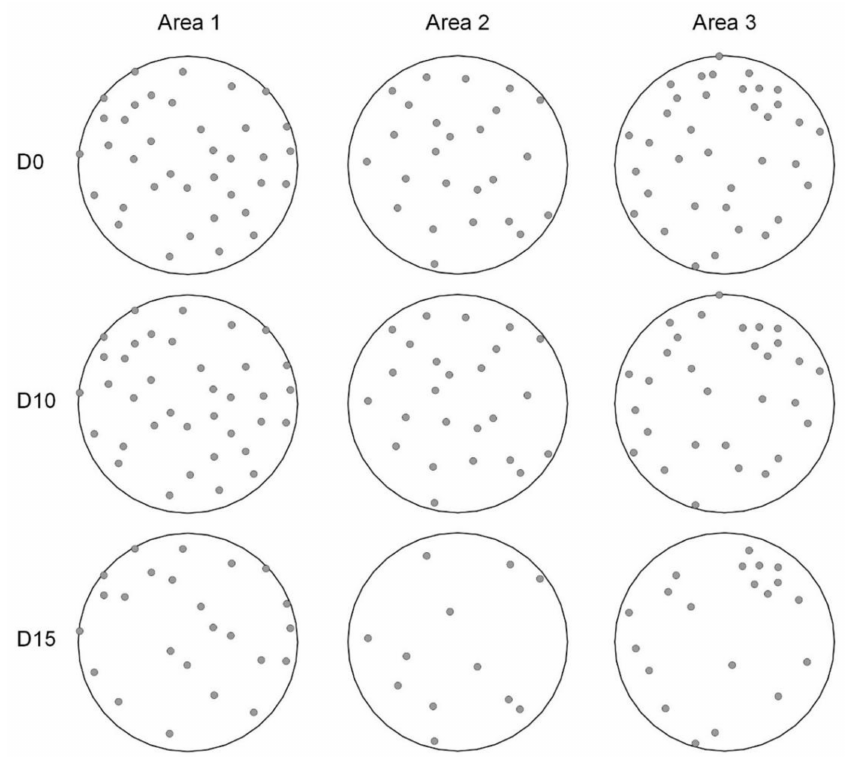
Figure 5. Single-tree position in the three areas estimated with D10 and D15 scans vs the reference data (D0 scan).